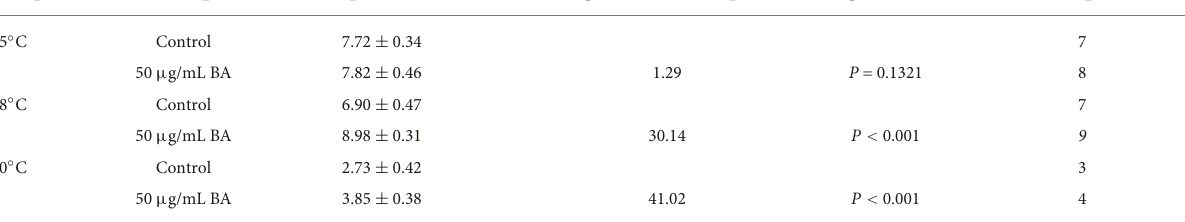
Figure 4A . Mean lifespan values were calculated by a log-rank test. P -value was calculated for control and treatment group.